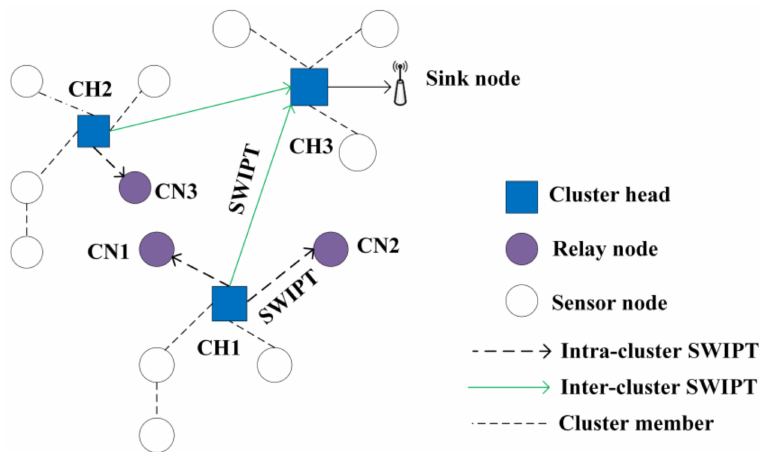
Figure 8. SWIPT-enabled clustered